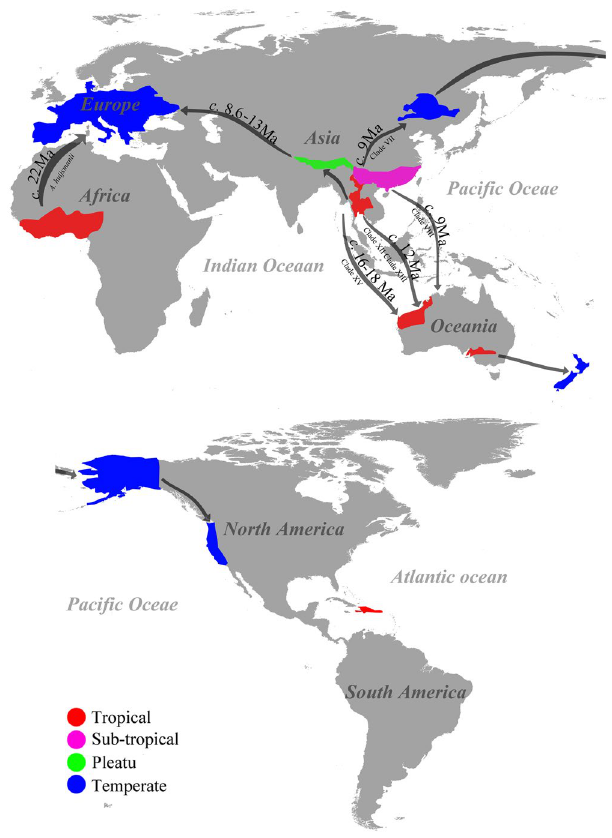
Figure 3. The hypothesized dispersal routines of species of Agaricus section Minores . The world map delimits the distribution areas of species involved in this study, and arrows indicate the major biogeographical events. Map was generated by ArcGIS v10.1